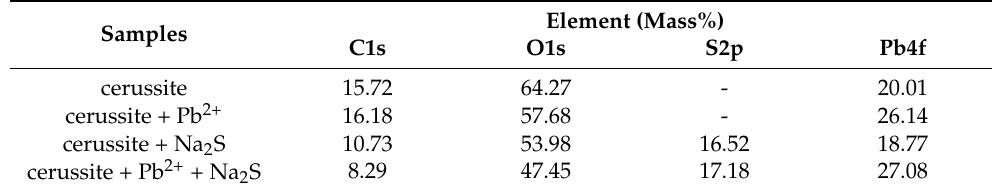
Table 1. Relative contents on the cerussite surface under different